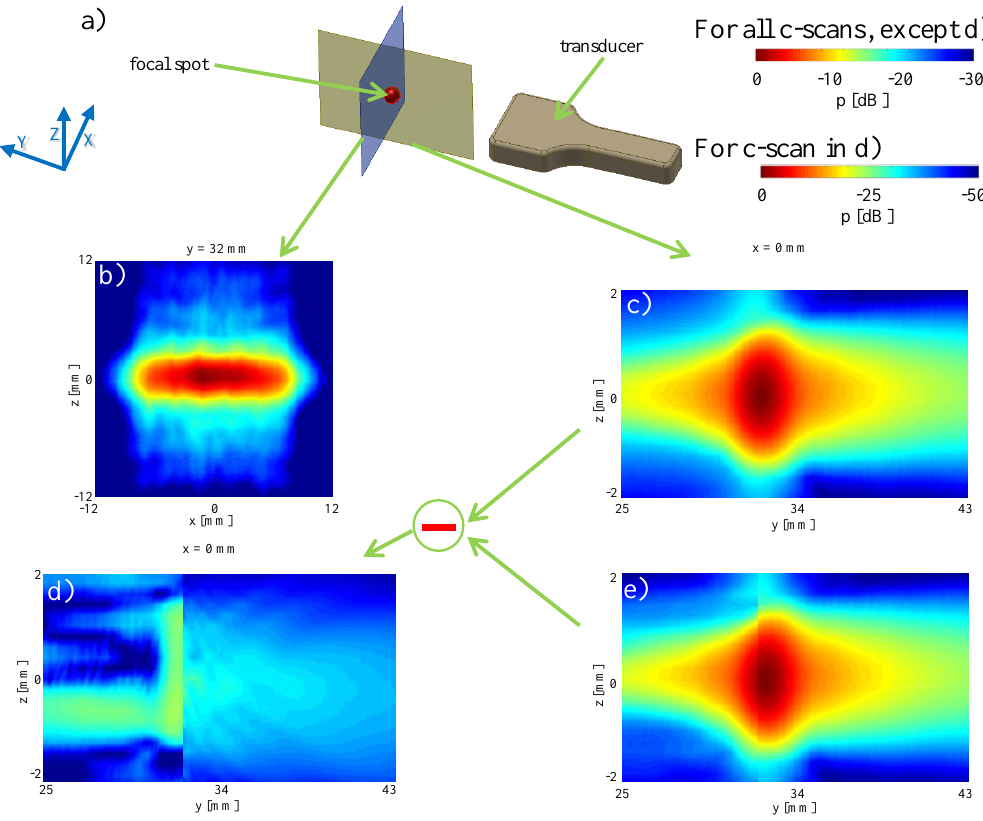
Figure 6. Characterizing the focal spot: ( a ) setup; ( b ) x , z plane measurement 32 mm in front of the transducer; ( c ) y , z plane measurement in the middle of the transducer ( x = 0 mm); ( d ) difference between the measured and simulation sound field; ( e ) simulation of the pressure distribution around the focal spot based on the re-radiation